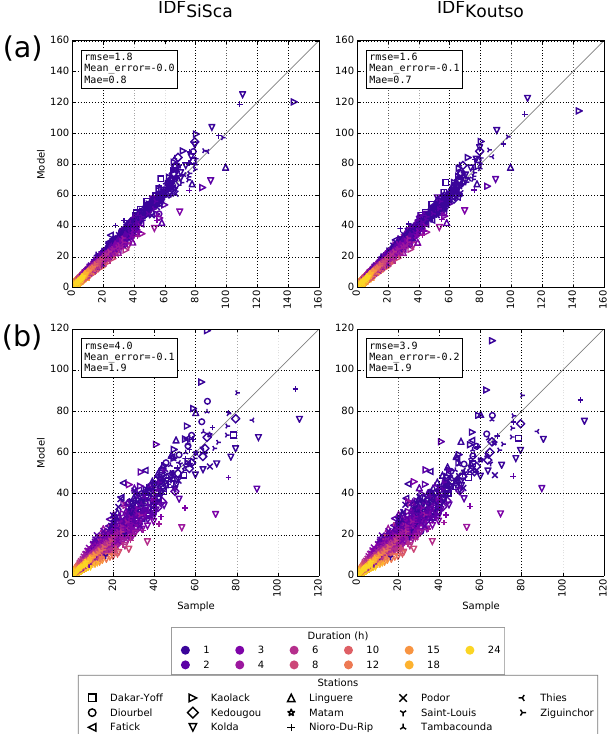
Figure 5. Quantile–quantile plots for both IDF models for the different durations and for all stations (global scores in the leg- end): (a) in calibration mode; (b) in validation mode; left panel for IDF SiSca ; right panel for IDF Koutso . The x axis and y axis units are mmh − 1